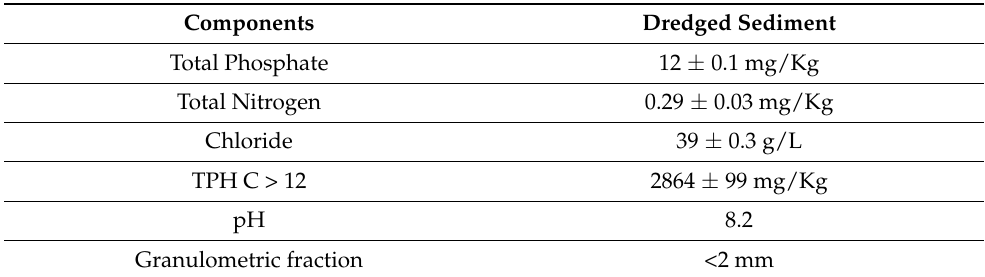
Table 1. Chemical/physical characteristics of the dredged